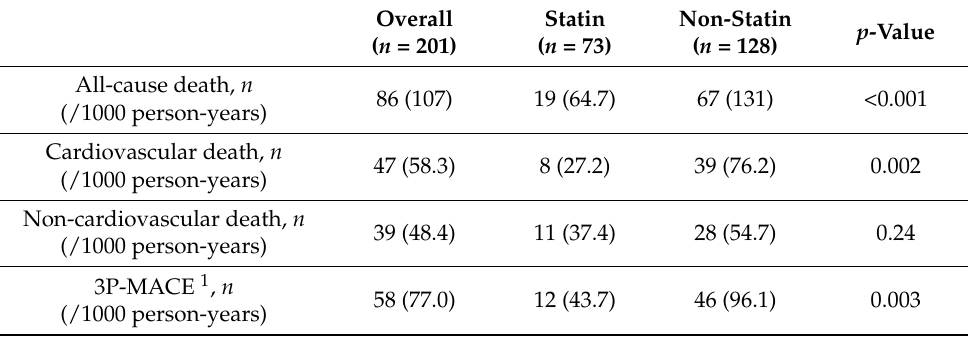
Table 2. Overall incidence of cardiovascular events (per 1000 person-years).